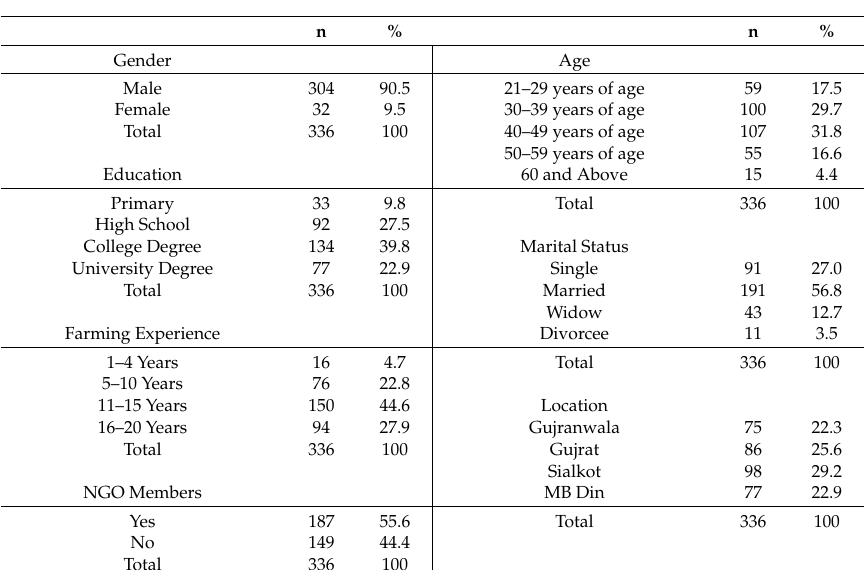
Table 1. Profile of the Respondents.